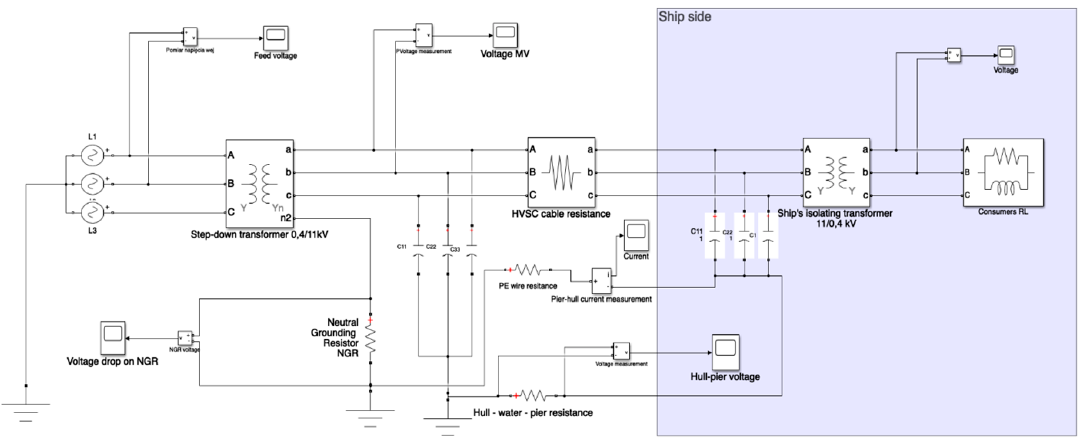
Figure 8. Simulink Model #1 of a ship’s ungrounded LV system and stray currents flowing from the hull to the pier through seawater.